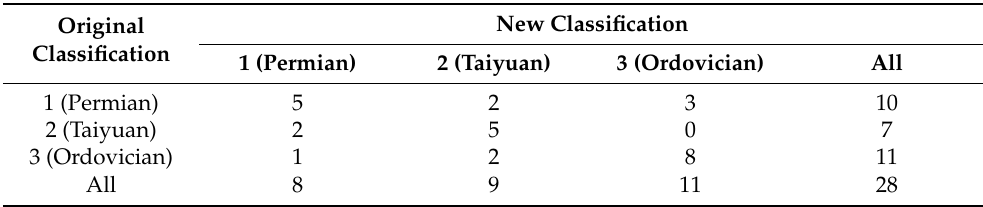
Table 11. Retrospective discrimination results of Bayes multi-class LDA function for conventional ions.